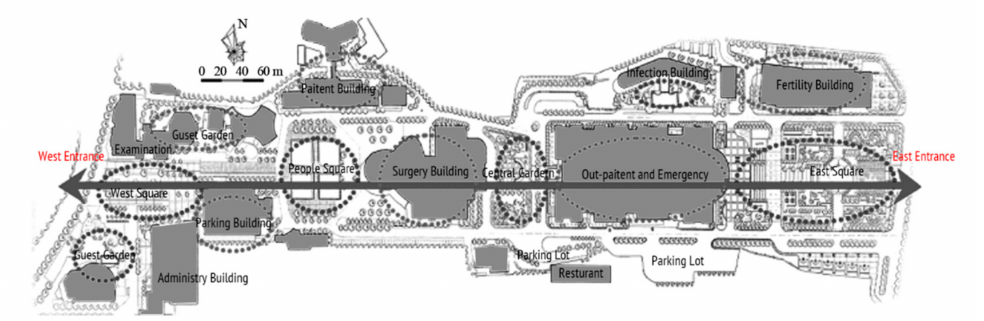
Figure 2. Site plan of Southwest